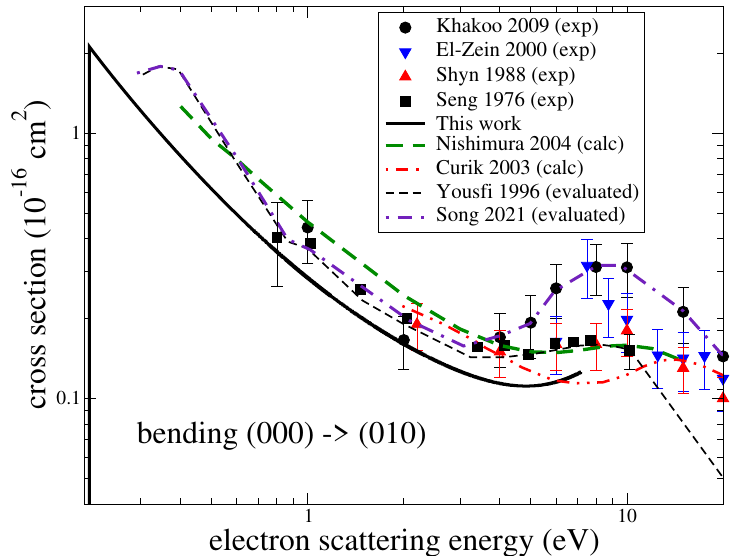
Figure 4. A comparison of cross sections available in the literature for the excitation of the bending mode ( 000 ) → ( 010 ) . The black solid line is the theoretical result obtained in this